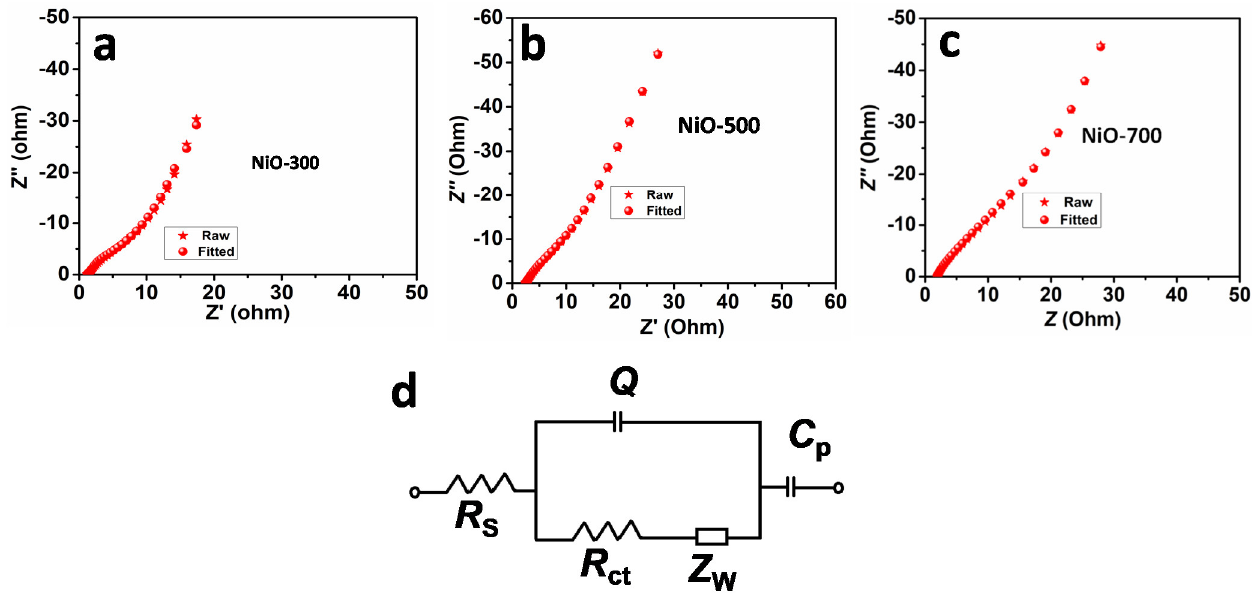
Figure 7. EIS of the ( a ) NiO-300, ( b ) NiO-500, ( c ) NiO-700 electrodes, and ( d ) equivalent